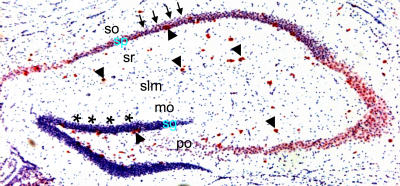
CB1 Expression Levels Vary Widely in the Mouse Hippocampal Formation.In cortex, CB1 mRNA is highly expressed in a very restricted set of interneurons and more moderately expressed in a broader population of principal neurons. A representative coronal section through the hippocampal formation of mouse brain is shown. Nonradioactive in situ hybridization was used to identify CB1 mRNA-containing cells. The very highest levels (darkest red) are found in a restricted subset of cells (arrowheads) that are distributed throughout the hippocampal formation. Other studies have shown these to be CCK-containing GABAergic interneurons. Intermediate levels (light pink) are found in the principal neurons of CA1 (arrows) and CA3. Dentate granule cells (asterisks) do not express CB1 mRNA and provide a measure of the background inherent in this technique. Nuclei are identified by toluidine blue counterstaining. This general pattern of expression is recapitulated throughout the neocortex and amygdala. mo, molecular layer; po, polymorphic layer; sg, granule cell layer; slm, stratum lacunosum; so, stratum oriens; sp, stratum pyramidale; sr, stratum radiatum. (Original image provided by Martin Häring.)